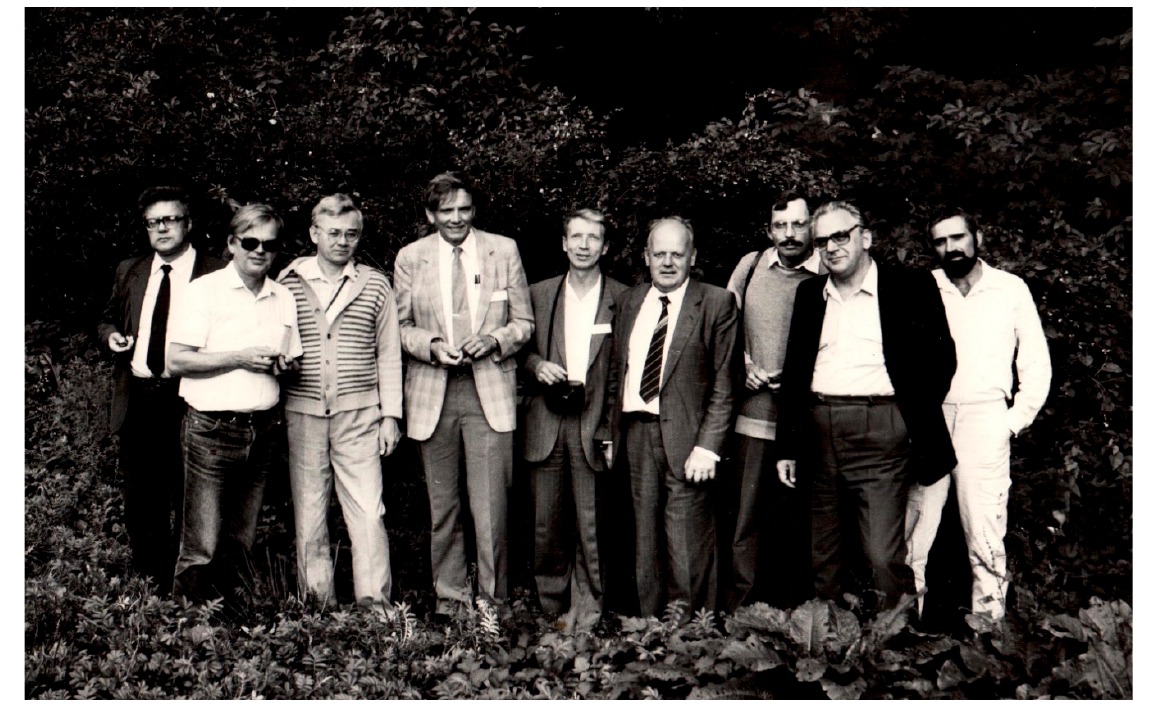
Figure 5. Among the participants of the XXIV Congress AMPERE on magnetic resonance and related phenomena in Poznan, 1988: J. Hyde (4th from the left), Yu.V. Yablokov (in the center), S.S. Shushkevich (4th from the right), V.N. Linev (3th from the right). Source: personal archive of V.N. Linev.